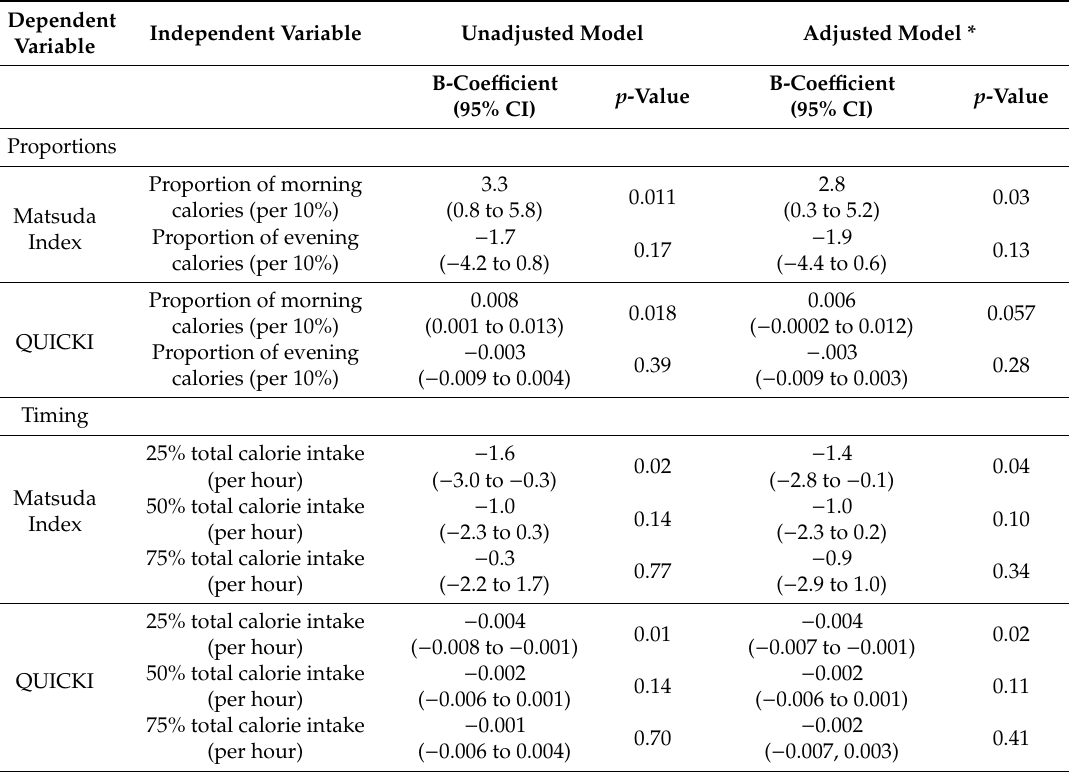
Table 3. Associations between insulin sensitivity and dietary proportion variables using linear regression models ( n =